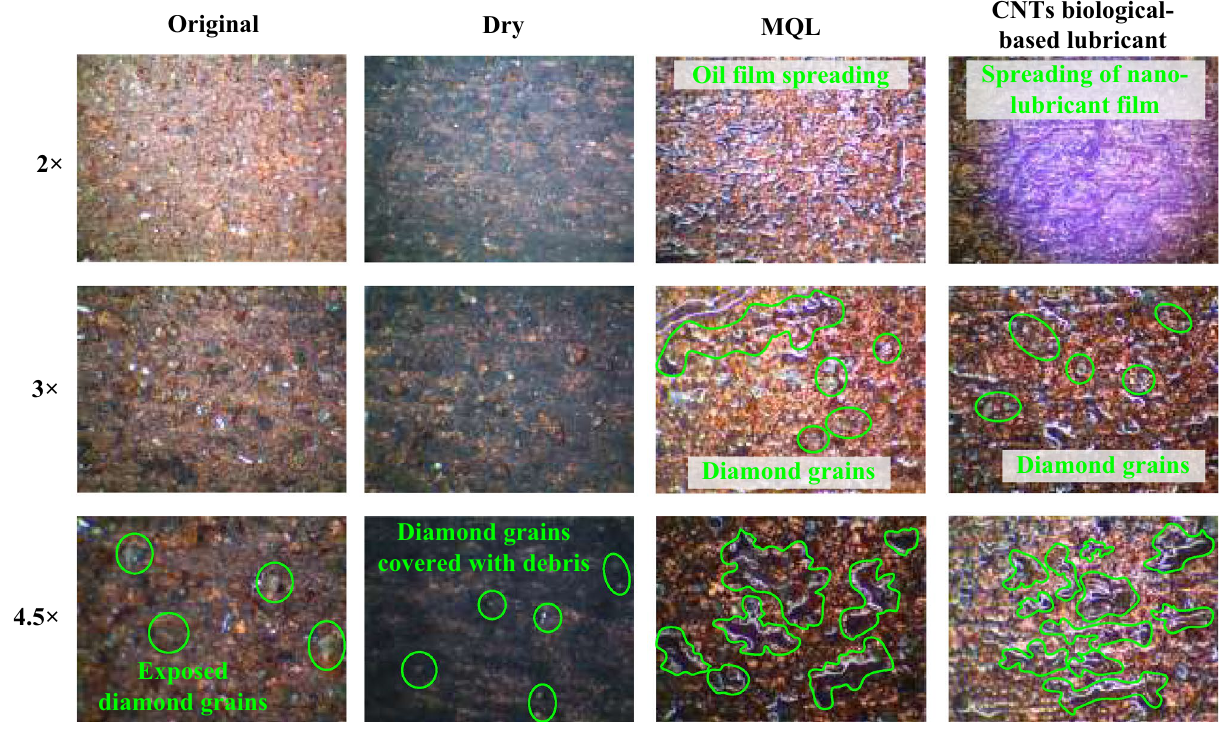
Figure 10. Comparisons of grinding wheel blockage under different lubrication conditions. Figures were created using the Microsoft Visio sofware (version